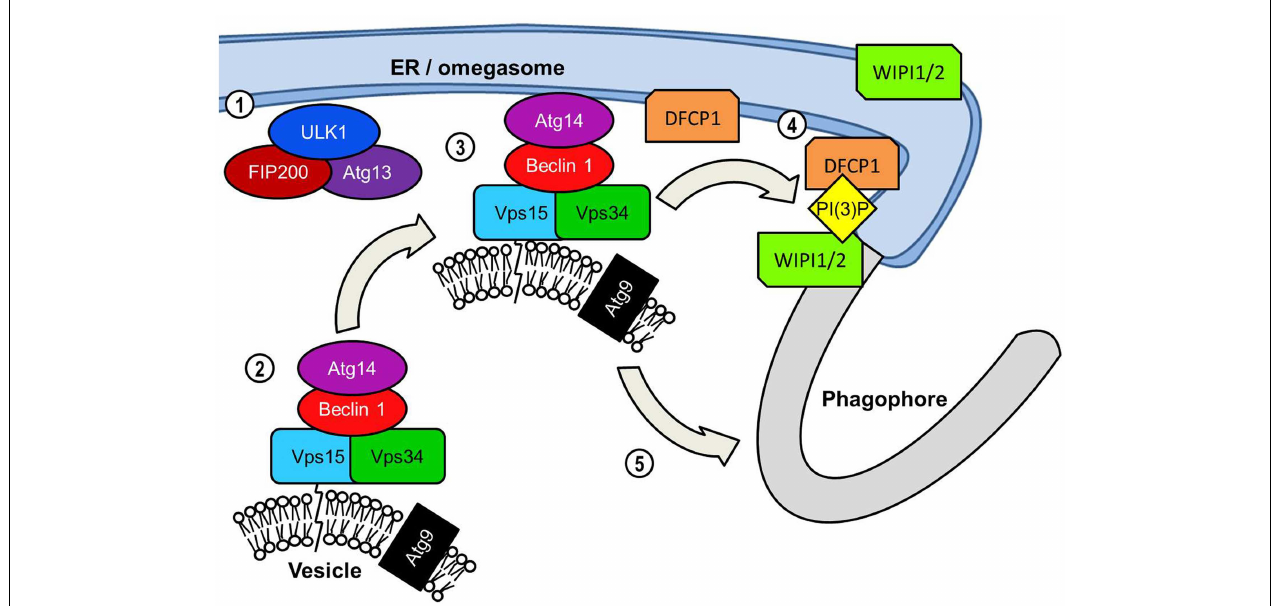
depicted on the same vesicle as the Beclin 1 complex for convenience.The extent to which vesicular Beclin 1 and Atg9 overlap in their distribution is unclear.The inclusion of the Atg14 protein recruits the Beclin 1 complex specifically to the ER.This may serve two functions in assembly of the autophagosome.The first and perhaps most crucial function is the generation of PI(3)P at the omegasome and/or phagophore, which is essential for the recruitment of many effector proteins required for autophagosome assembly. PI(3)P production results in an accumulation of PI(3)P-binding protein DFCP1 at the omegasome membrane, the functional significance of which is unknown. ER-associatedWIPI proteins,WIPI1 andWIPI2 also bind PI(3)P and are essential in the transition from omegasome to the double membrane